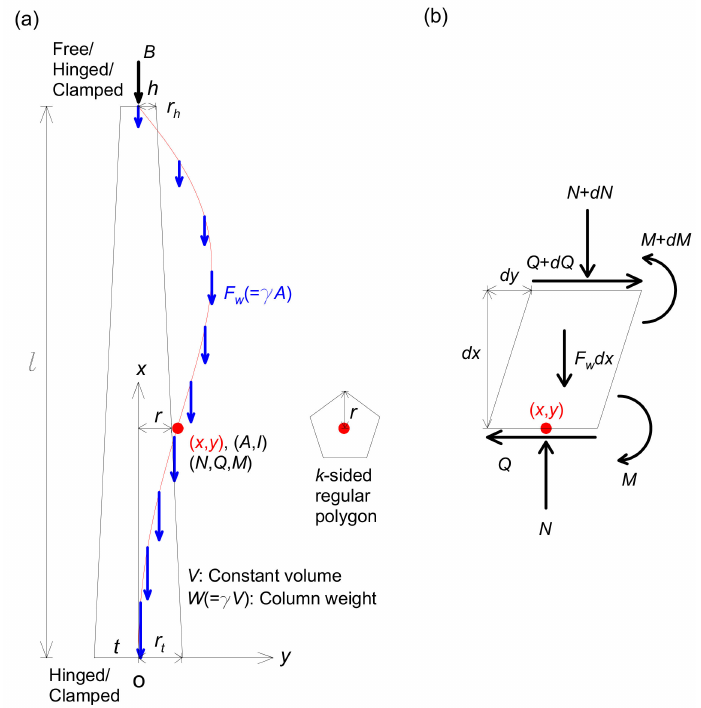
Figure 1. ( a ) Schematic diagram of a buckled heavy column with a k -sided regular polygon cross- section and ( b ) forces imposed on a buckled